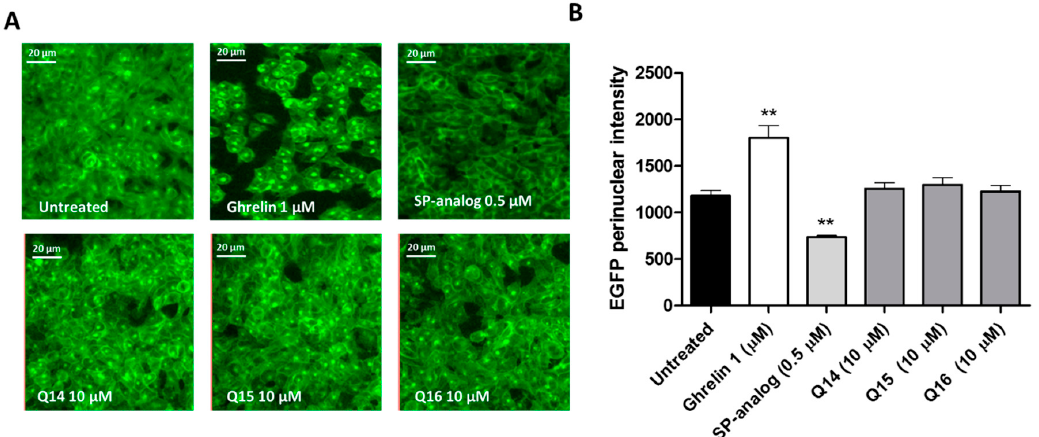
Figure 5. Quinolone compounds’ effects on the GSH-R1a internalization. Quinolone compounds do not affect GSH-R1a internalization. ( A ) Representative images are depicted following different treatments: the untreated control (assay buffer), ghrelin (1 µM), [D-Arg1, D-Phe5, D-Trp7,9, Leu11]-substance P (SP-analog) (0.5 µM) and quinolones Q14, Q15 and Q16 (10 µM). ( B ) The graph represents